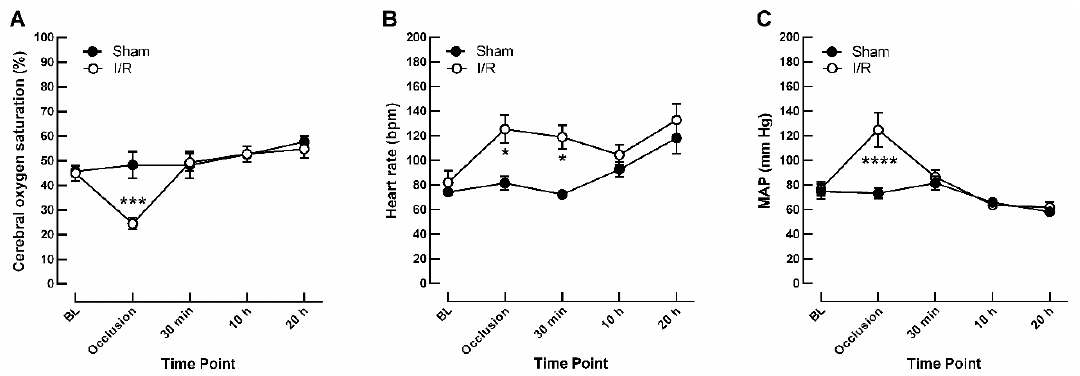
Figure 1. Time courses of cerebral oxygen saturation measured by INVOS™ 5100C ( A ), of heart rate ( B ) and of mean arterial blood pressure (MAP) ( C ) at baseline (BL), during the occlusion time of 12 min (occlusion), 30 min after releasing the occlusion, and after a reperfusion time of 10 and 20 h. Data are expressed as mean ± SE ( n = 6 per timepoint and group, * p < 0.05, *** p < 0.001, **** p < 0.0001). I/R = ischemia-reperfusion.